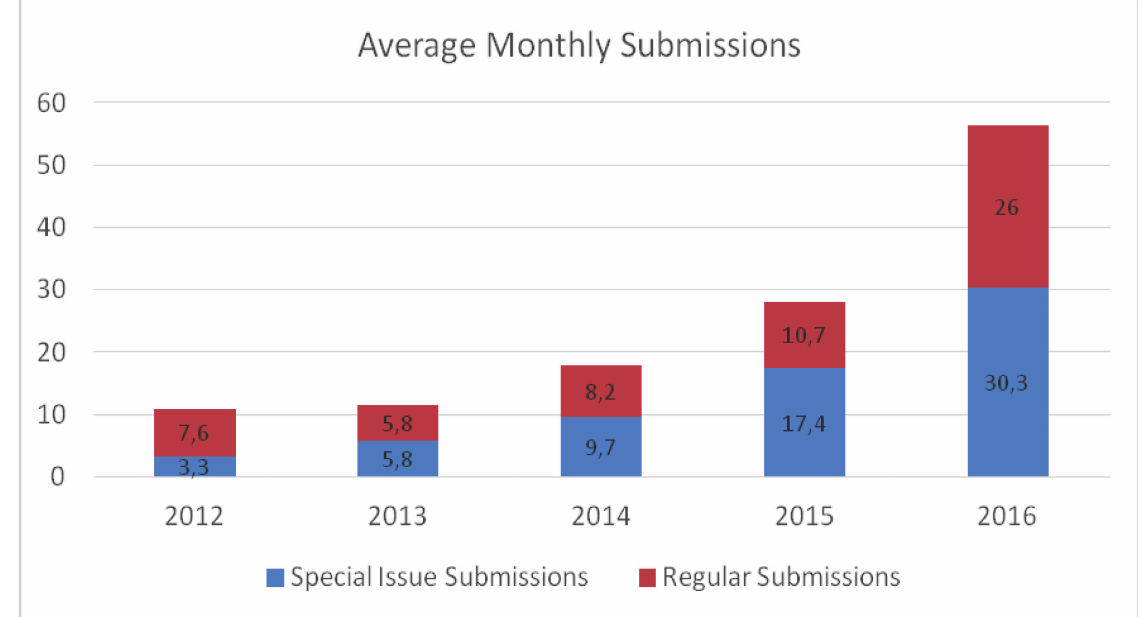
The figure below shows the geographical distribution of new submissions from 2012 to 2016.